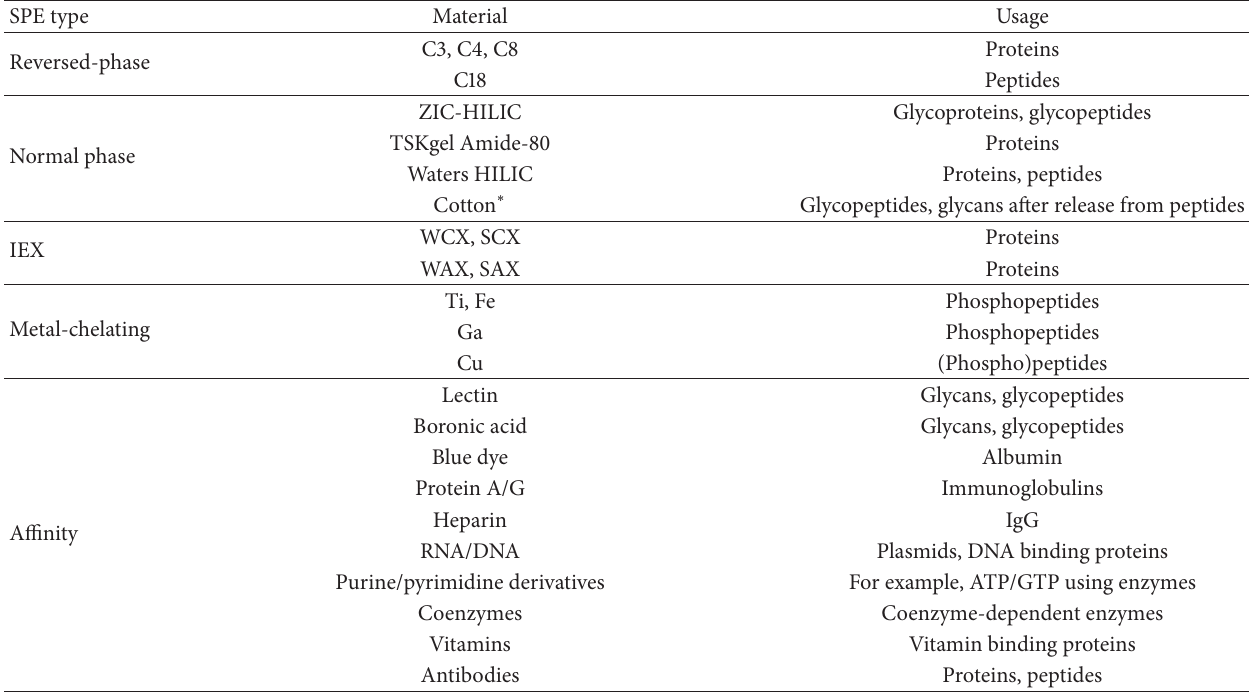
Table 1: Various sorbents used in protein